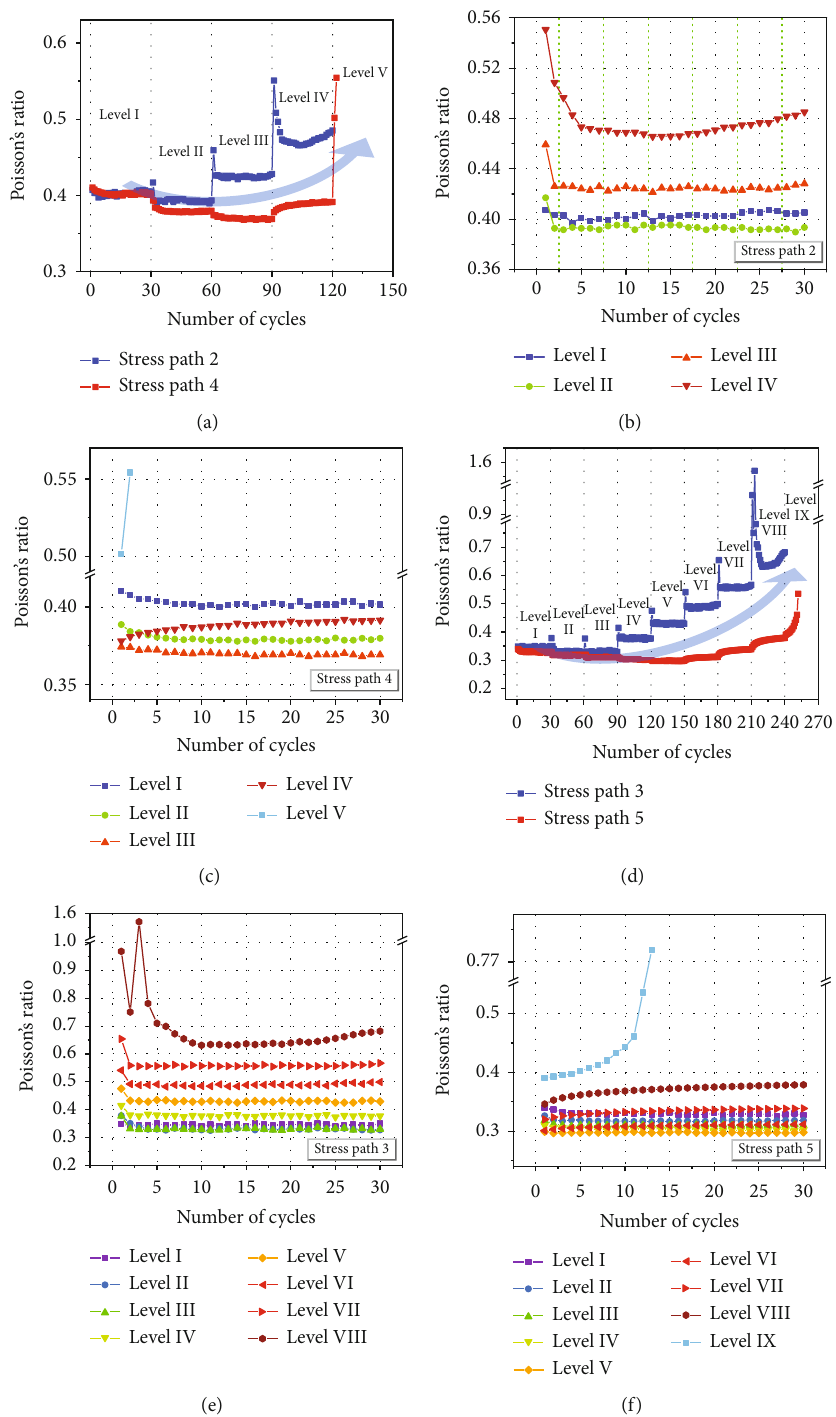
Figure 8: Poisson ’ s ratio of specimen evolution process under di ff erent stress paths. (a) μ paths 2 and 4; (b) in fl uences of stress level on μ d under stress path 2; (c) in fl uences of stress level on μ d under stress path 4; (d) μ d evolution with number of cycles under stress paths 3 and 5; (e) in fl uences of stress level on μ d under stress path 3; (f) in fl uences of stress level on μ d under stress path